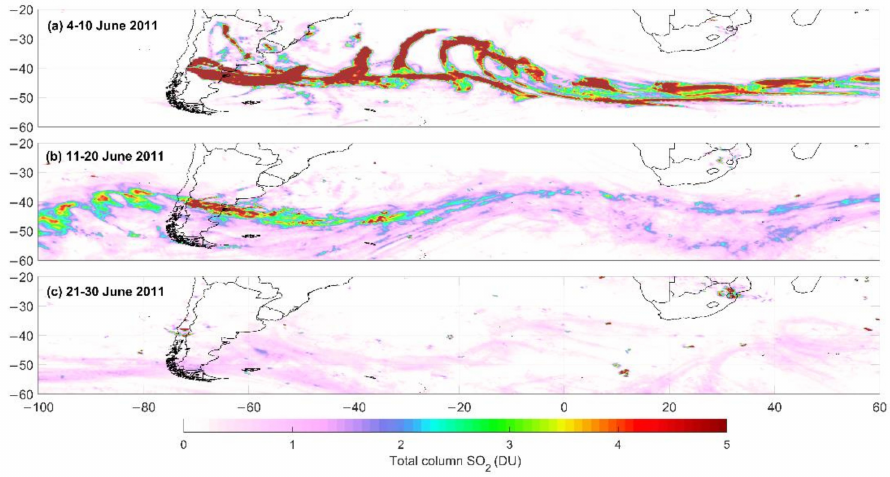
Figure 7. Composite image of Infrared Atmospheric Sounding Interferometer (IASI) SO 2 column for 4–10 June 2011 ( a ), 11–20 June 2011 ( b ) and 21-30 June 2011 ( c ).